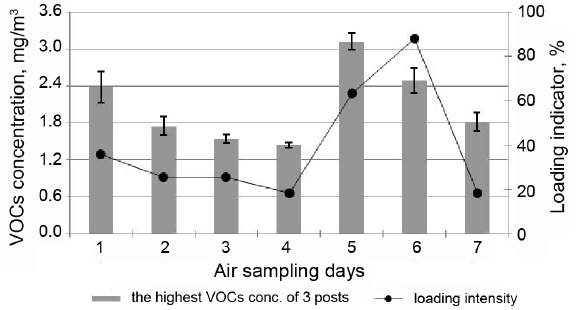
Fig. 6. Dispersion of VOCs concentration and loading indicator in winter The lowest VOCs concentration value (1.44 mg/m 3